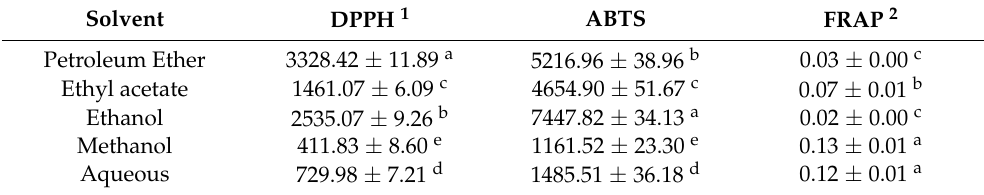
Table 7. Antioxidant activity (DPPH, ABTS, and FRAP assay) of A. iva extracts ( n = 3 samples, 3 replicates per sample).